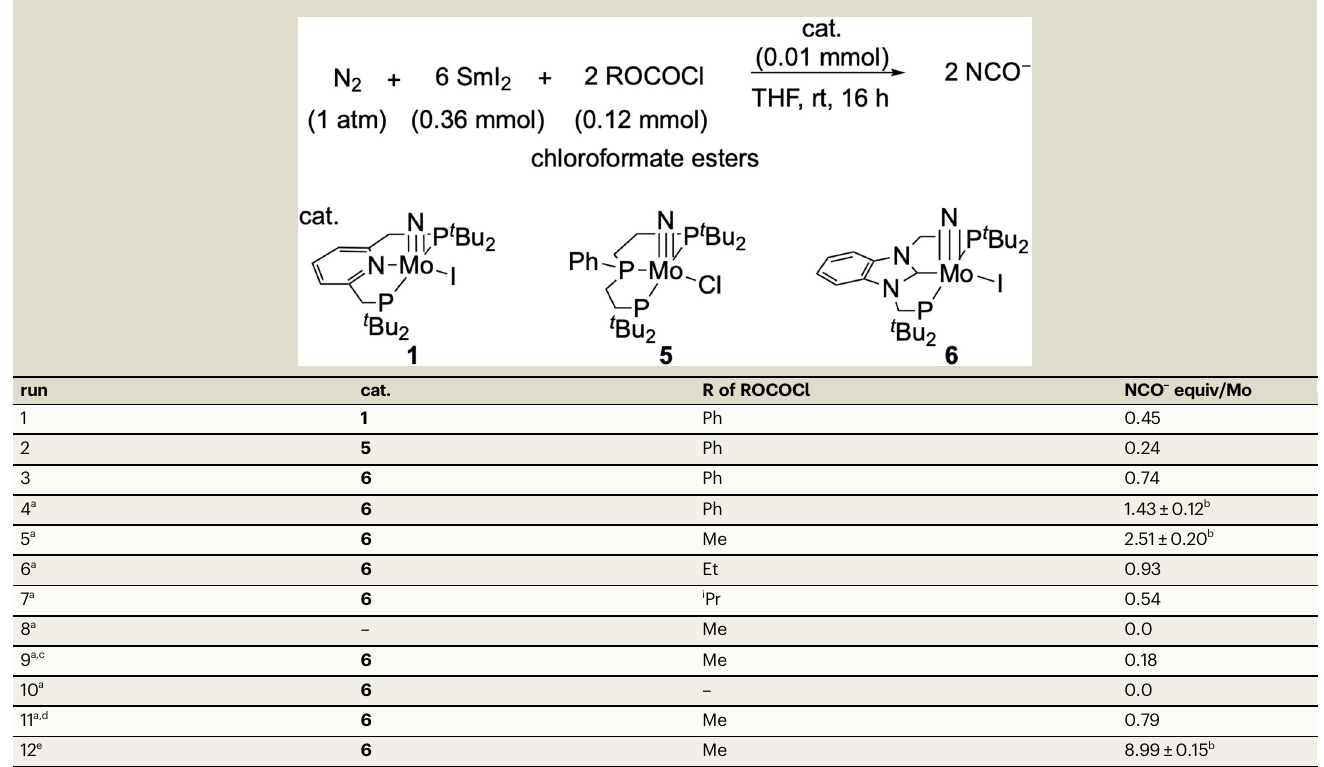
Table 1 | Molybdenum-catalysed formation of NCO − from reaction of N 2 with SmI 2 and chloroformates under ambient reaction conditions